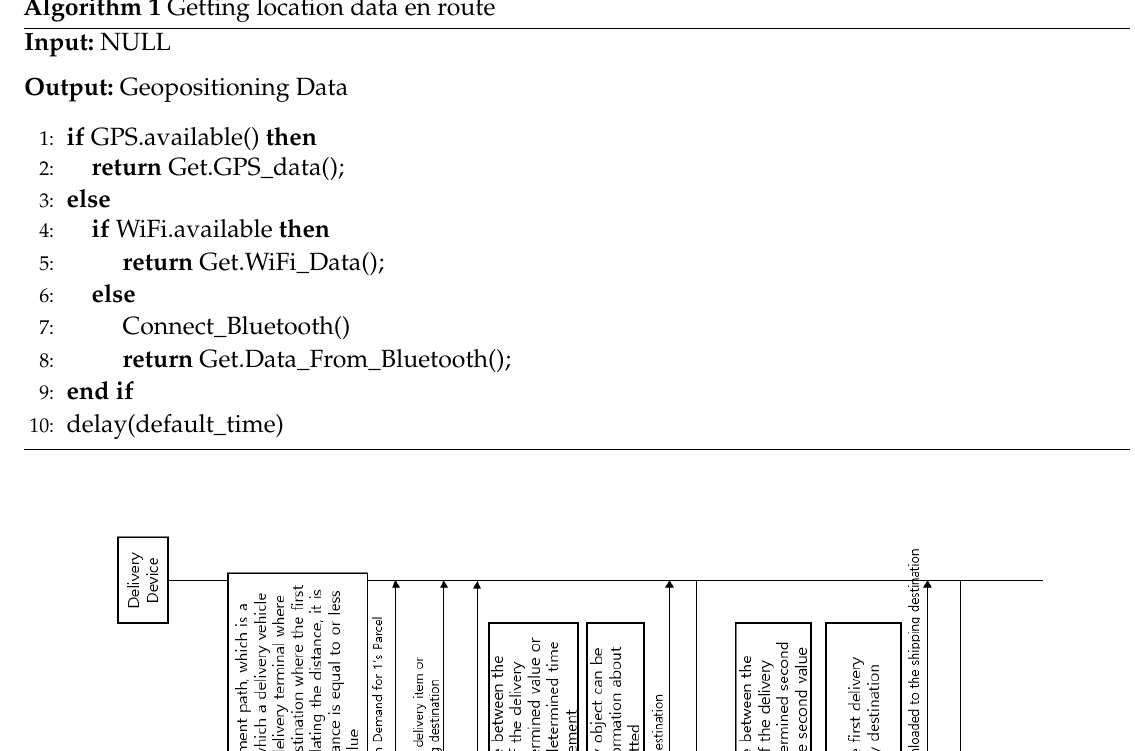
Algorithm 1 Getting location data en route